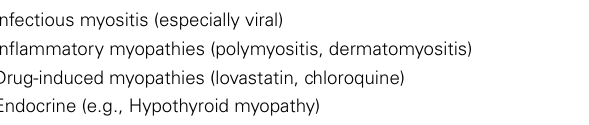
Table 4 | Muscle disorders associated with myalgias.